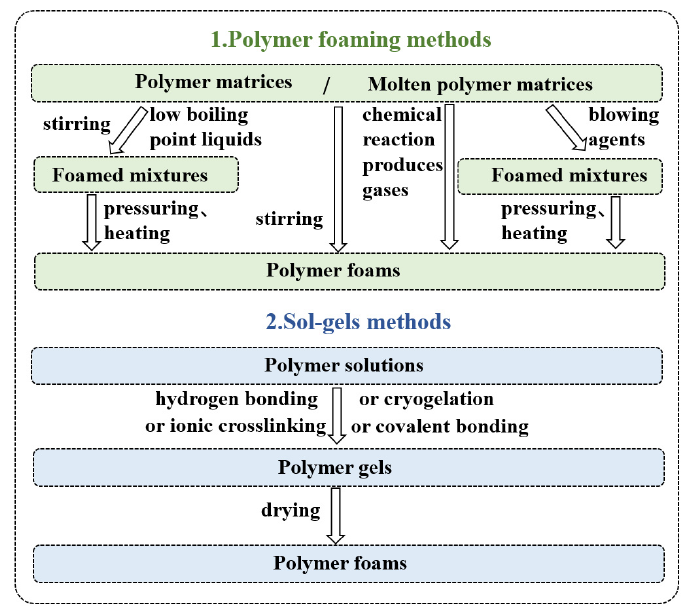
Figure 3. Preparation methods summary of polymer foams.